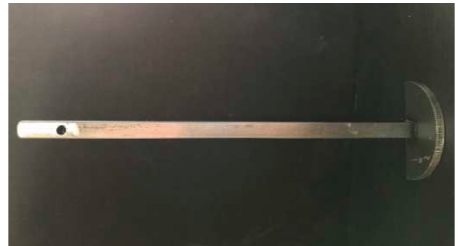
Figure 3: Plate anchor style.